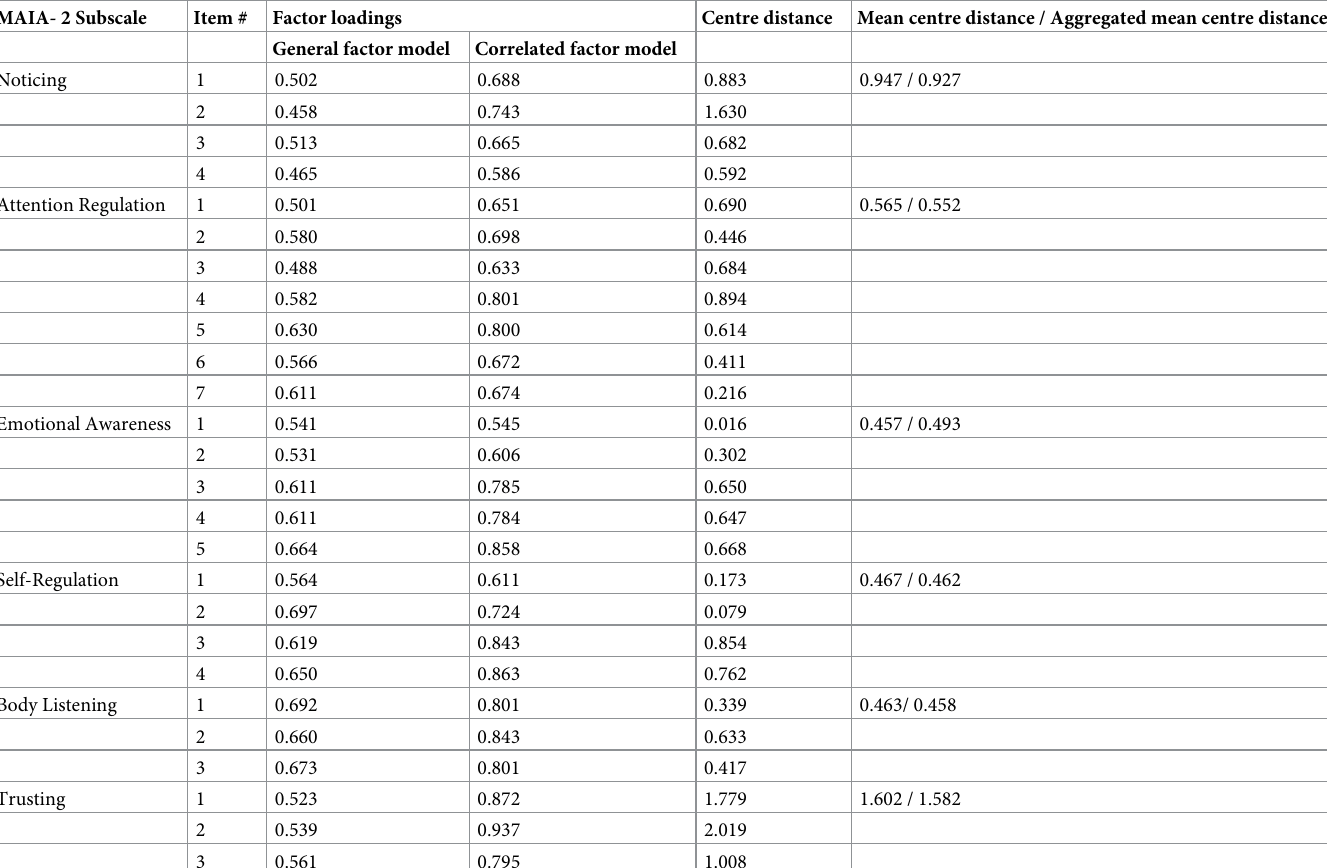
Table 4. Basic item pool visualisation calculations for multidimensional assessment of interoceptive awareness-2. MAIA- 2